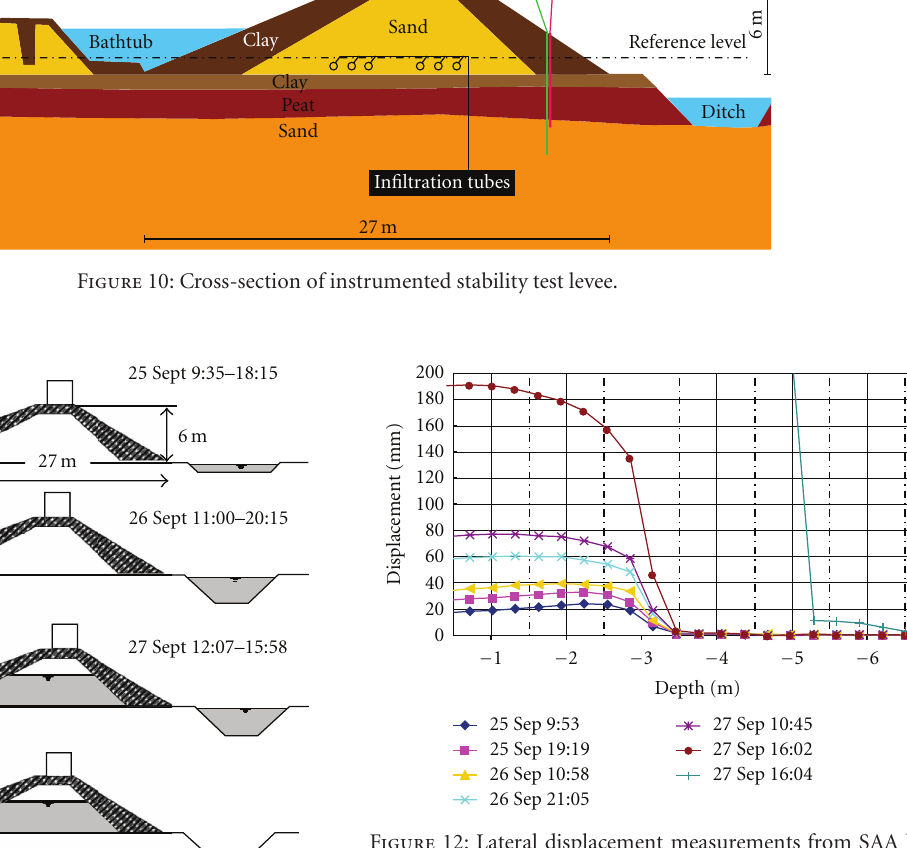
Figure 12: Lateral displacement measurements from SAA located in an instrumented cross-section at the middle of the test levee (center of levee shown in Figure